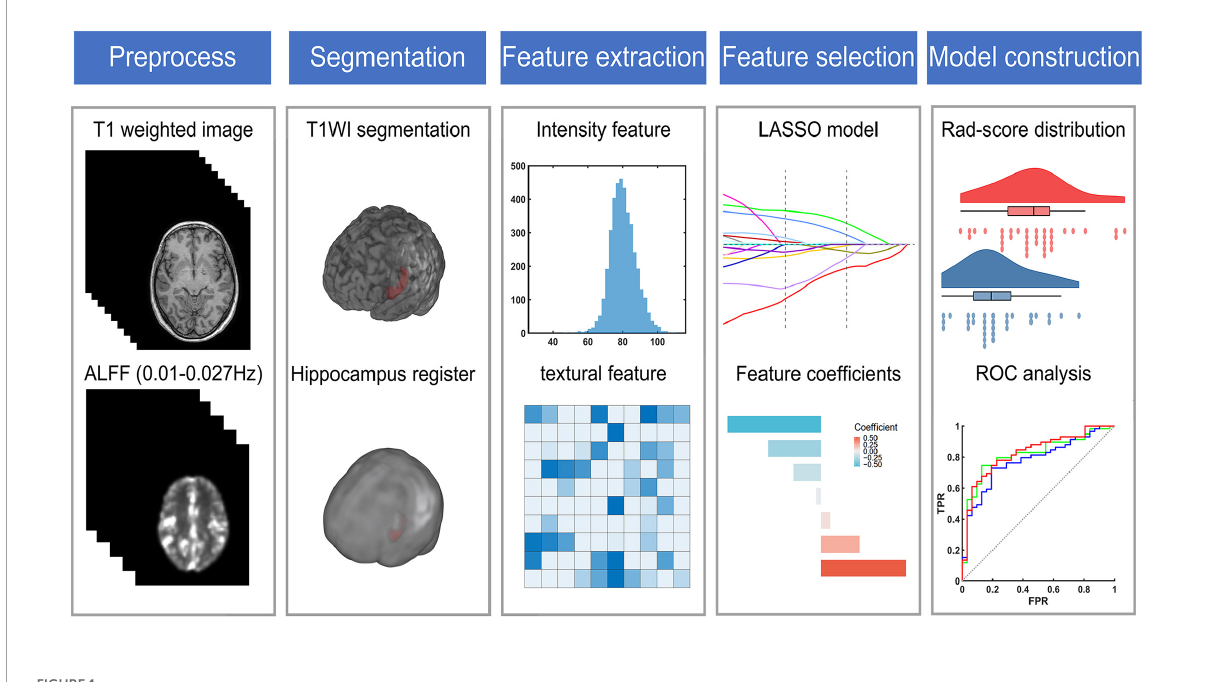
FIGURE1 The flow chart of radiomic analysis. ALFF, the amplitude of low frequency fluctuation; LASSO, the least absolute shrinkage and selection operator; ROC, receiver operating characteristic.